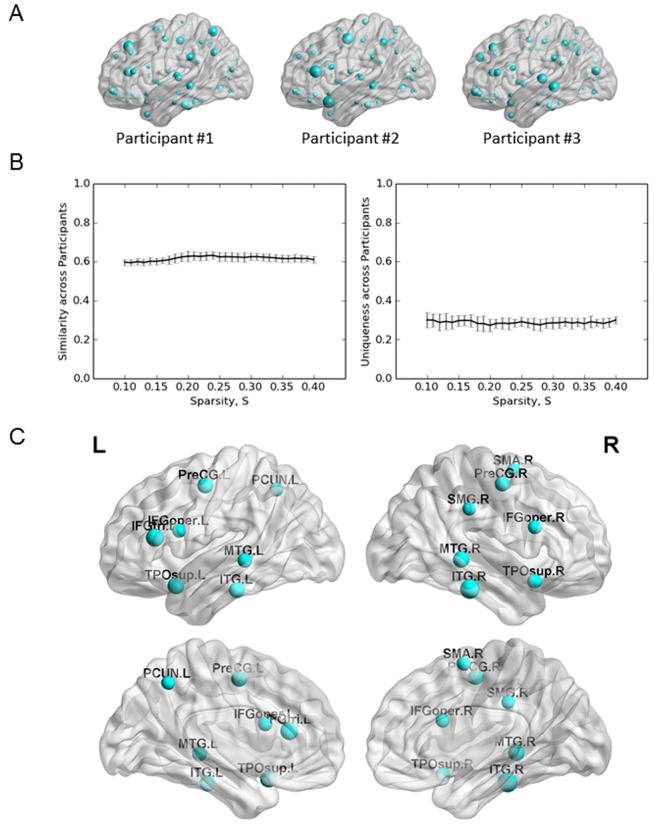
Spatial distribution of hubs within the morphometric network.(A) Three examples of the spatial distributions for betweenness. (B) The similarity (left) and uniqueness (right) of individual spatial distributions. (C) Hubs identified in this study. L: left; R: right. PreCG: precentral gyrus; IFGoper: inferior frontal gyrus opercularis; IFGtri: inferior frontal gyrus triangularis; SMA: supplementary motor area; SMG: supramarginal gyrus; PCUN: precuneus; TPOsup: superior temporal gyrus of temporal pole; MTG: middle temporal gyrus; ITG: inferior temporal gyrus.